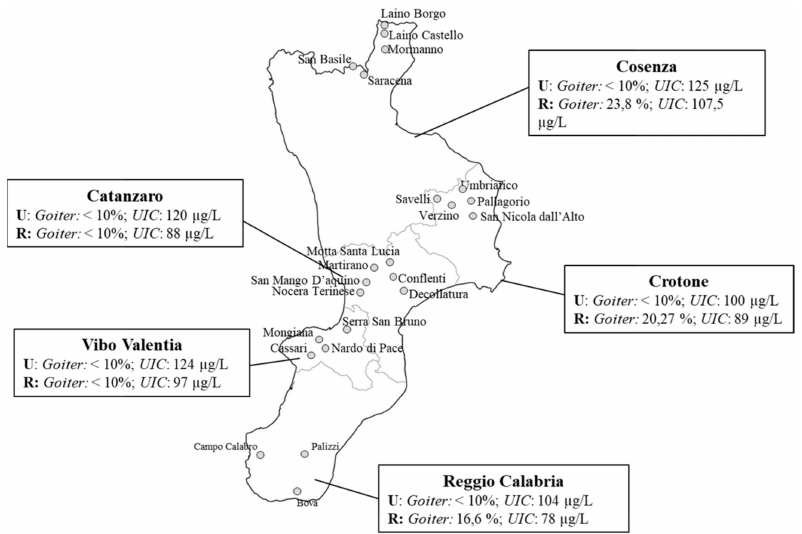
Figure 3. Goiter prevalence and median urinary iodine concentration in schoolchildren population from iodine su ffi cient urban areas (U) and rural areas (R) of the Calabria